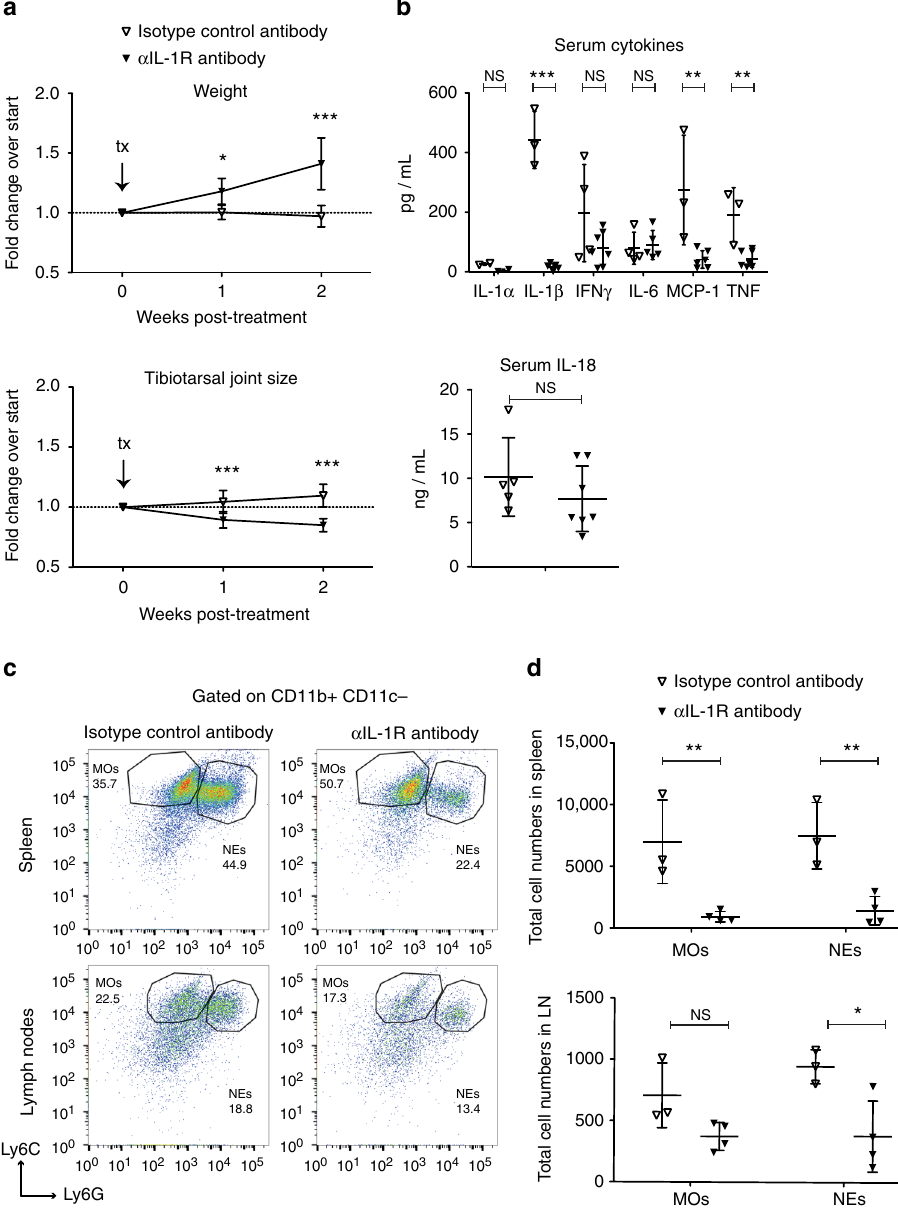
Fig. 6 Blocking IL-1R relieves disease symptoms. iOvaFla; LysM-Cre +/ − mice with signi fi cant joint swelling at 4.0 mm were administered either anti-IL-1R blocking antibody or isotype control every 3 – 4 days for 2 weeks. a Their weights and tibiotarsal joints were measured during that time ( n = 7 biological replicates per treatment). b Post-treatment serum cytokines measured by a BD Biosciences cytokine bead array and IL-18 ELISA. c Flow cytometry and d quanti fi cation of monocytes (MO; CD11b + Ly6C Hi Ly6G Lo ) and neutrophils (NE; CD11b + Ly6C Lo Ly6G Hi ). For each fl ow cytometry plot, the top row is from the spleen and the second row from peripheral and mesenteric lymph nodes. Each column represents a different treatment. Data in b – d are representative of three independent experiments. Error bars are s.d. Results were analysed with either a Mann – Whitney test or two-way ANOVA and Bonferroni post- tests; * p < 0.05, ** p < 0.01, *** p <